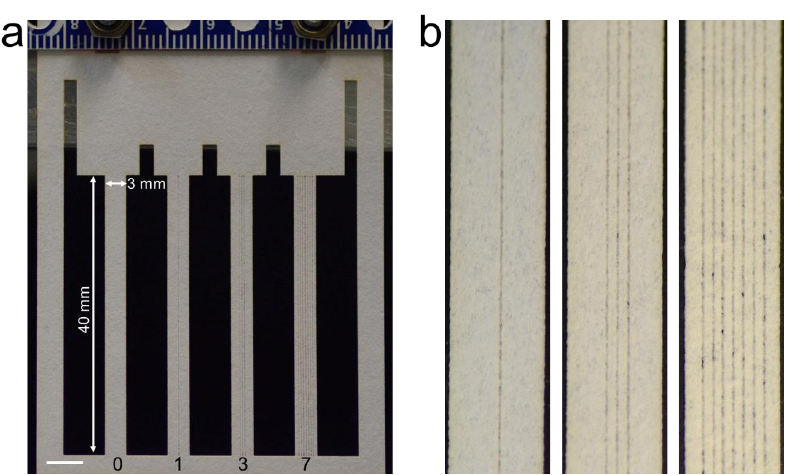
Figure A2. Close-up of the grooved channels. ( a ) The grooved test device, with four 3 mm wide, 40 mm long channels, etched with 0 grooves (unetched), 1, 3, and 7 grooves. Scale bar is 5 mm. ( b ) A close-up view of the grooves. The grooves are centered in the channels with 400 µm center-to-center spacing.